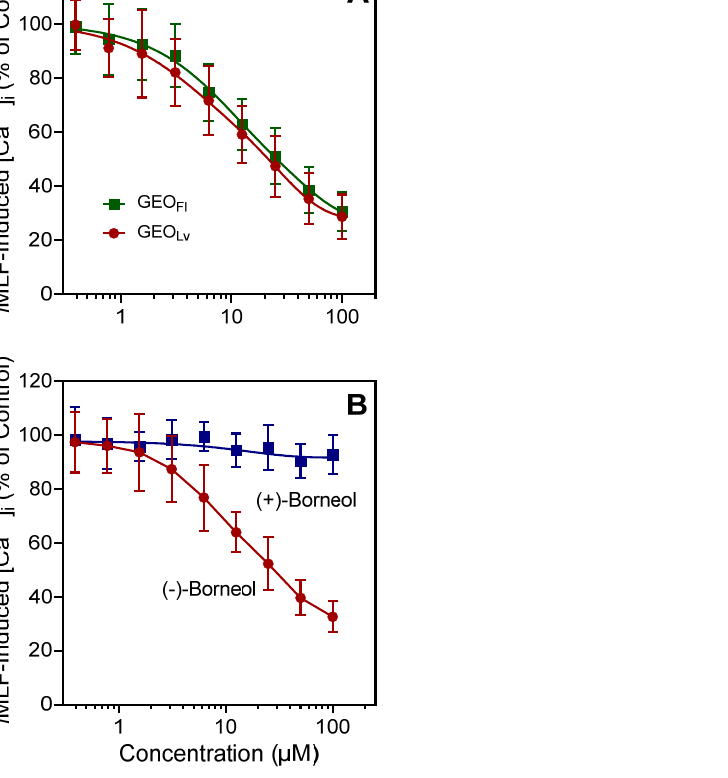
Figure 2. Effect of Grindelia essential oils or borneol on f MLF-induced neutrophil [Ca 2+ ] i . Human neutrophils were treated with the indicated concentrations of GEO Fl and GEO Lv ( A ), ( − )-borneol and (+)-borneol ( B ), or 1% DMSO (negative control) for 10 min. The cells were then activated by 5 nM f MLF, and [Ca 2+ ] i was monitored as described. The data shown are presented as the mean ± SD from one experiment that is representative of three independent experiments with similar